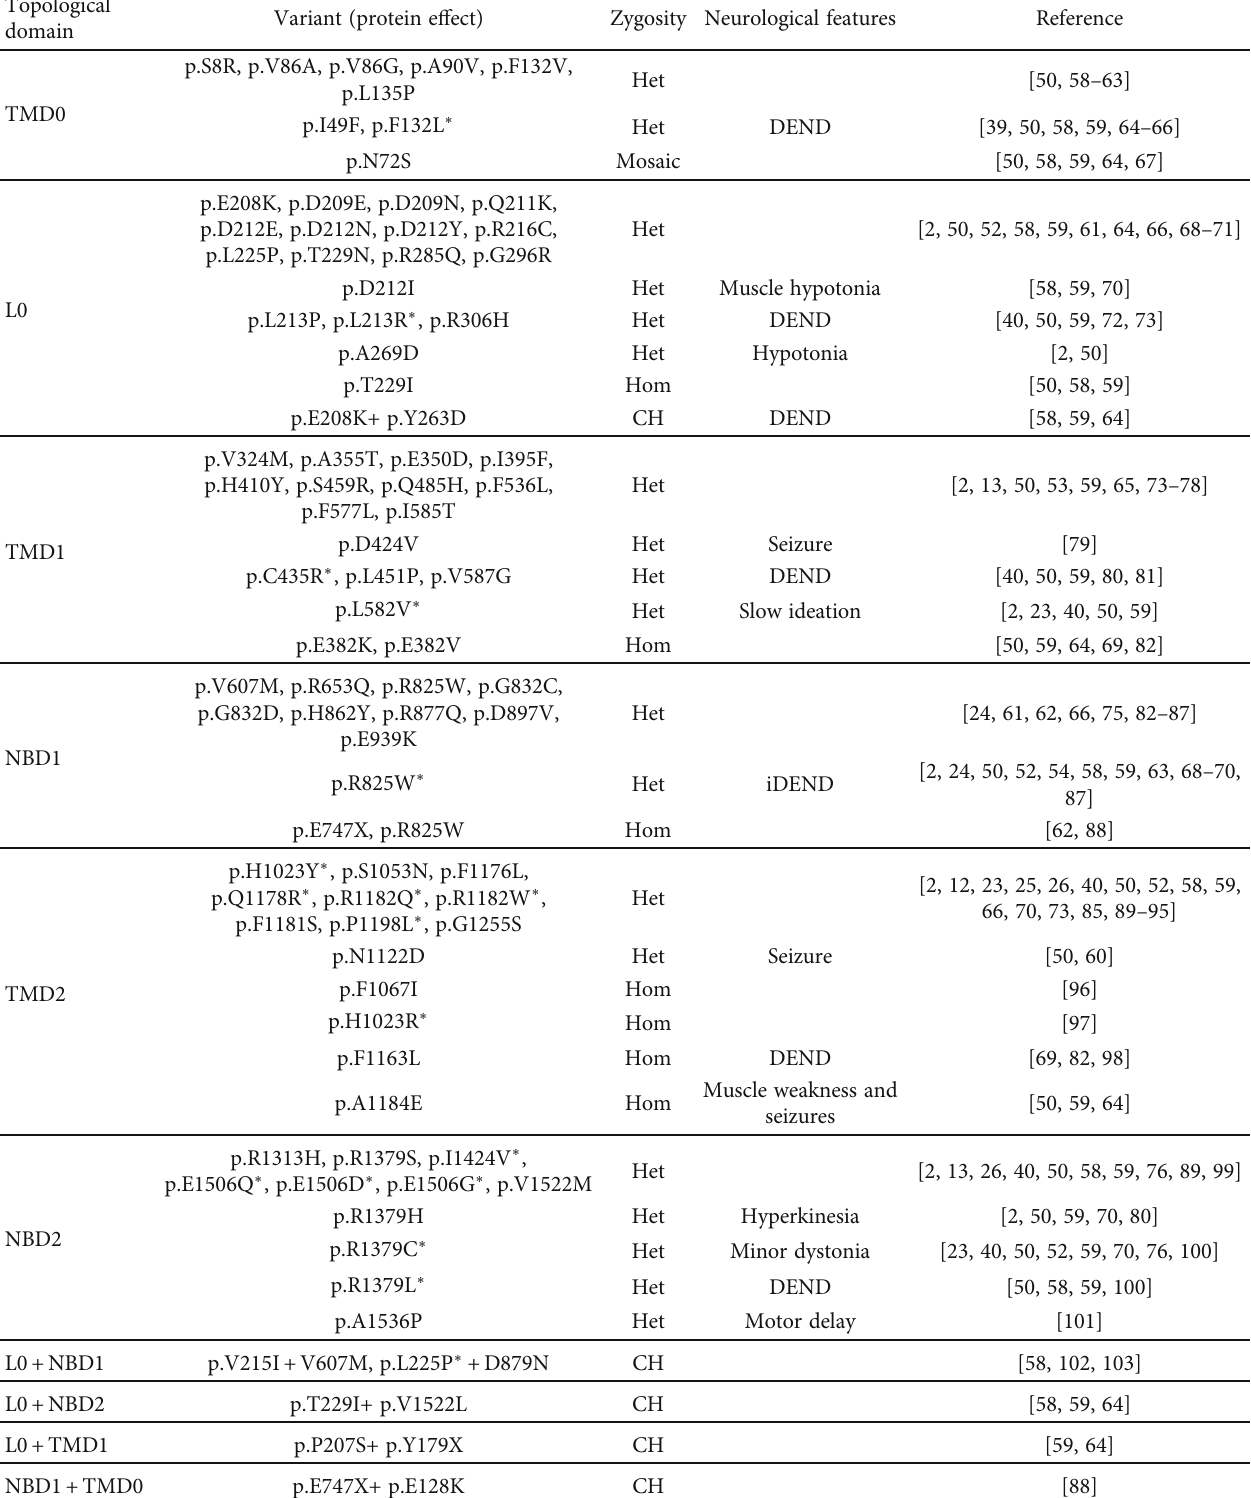
Table 1: Variants of ABCC8 causing neonatal diabetes mellitus reported in previous